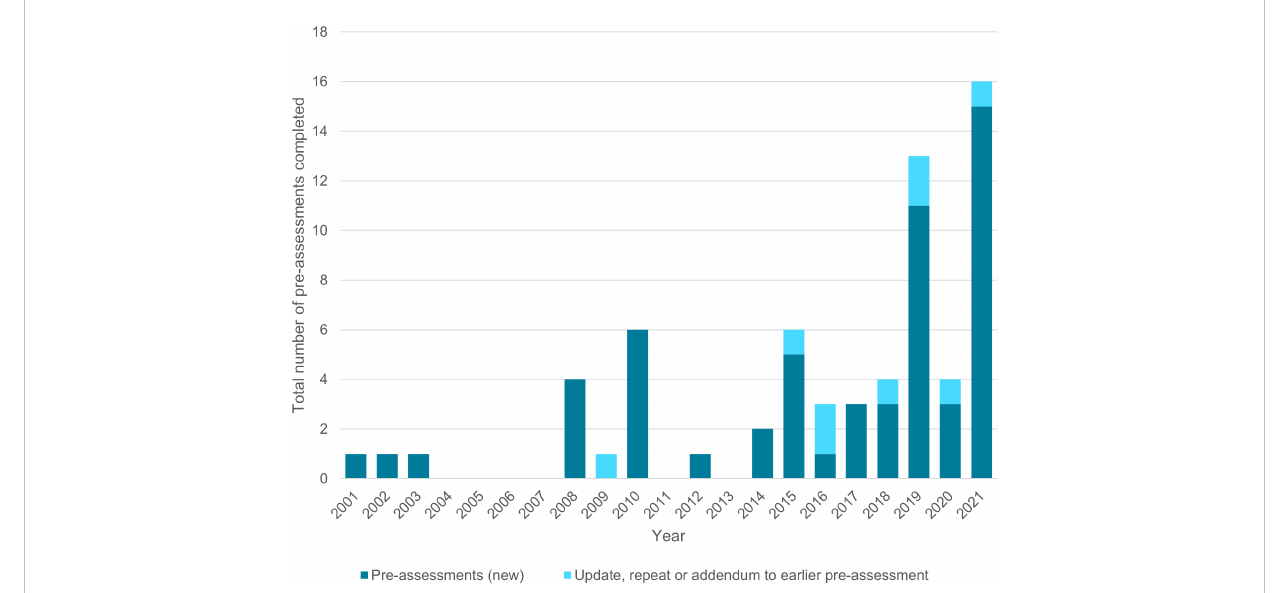
FIGURE 3 Number of known MSC pre-assessments by year for African fi sheries. Note that some fi sheries may have undergone more than one pre-assessment in different years against an updated version of the standard, or a pre-assessment was updated with new